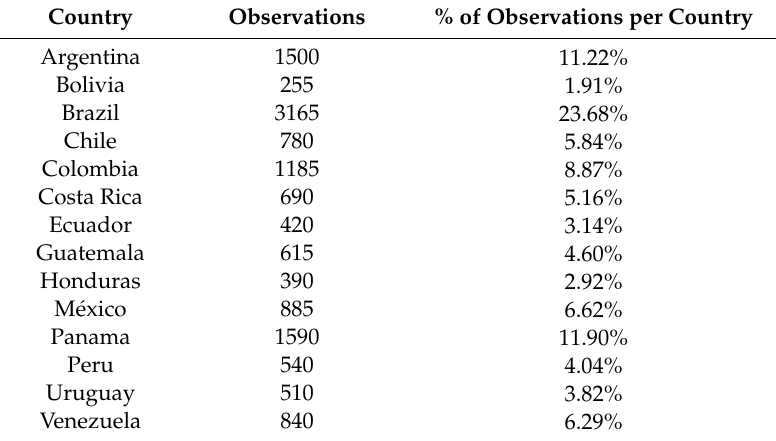
Table 1. Distribution of the observations across countries. Country